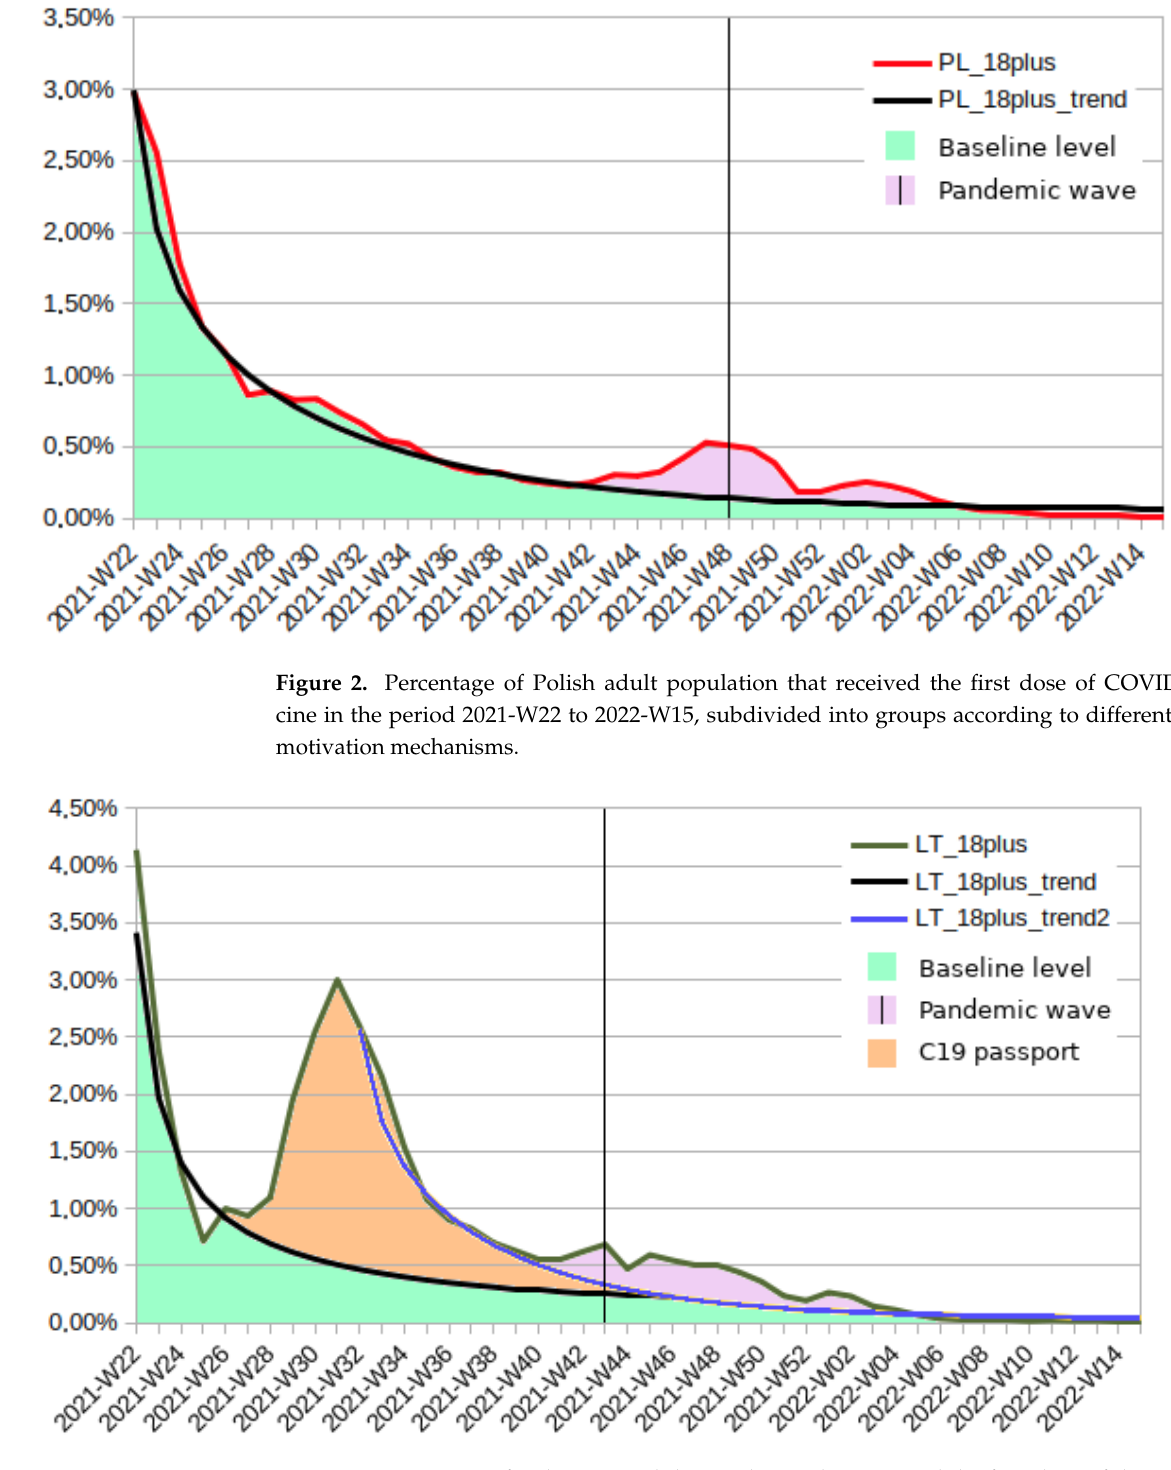
Figure 3. Percentage of Lithuanian adult population that received the first dose of the COVID-19 vaccine in the period 2021-W22 to 2022-W15, subdivided into groups according to different implied motivation mechanisms.